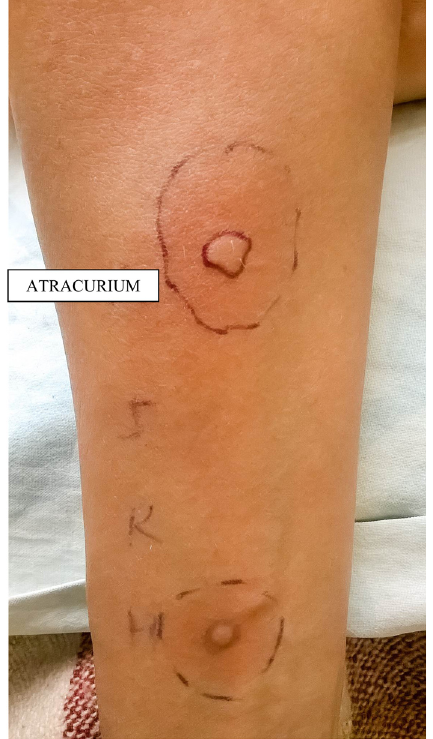
Figure 2: Positive skin prick test to atracurium due to cross - reactivity. The diameter of a wheal and erythema was 8 mm, erythema – 28